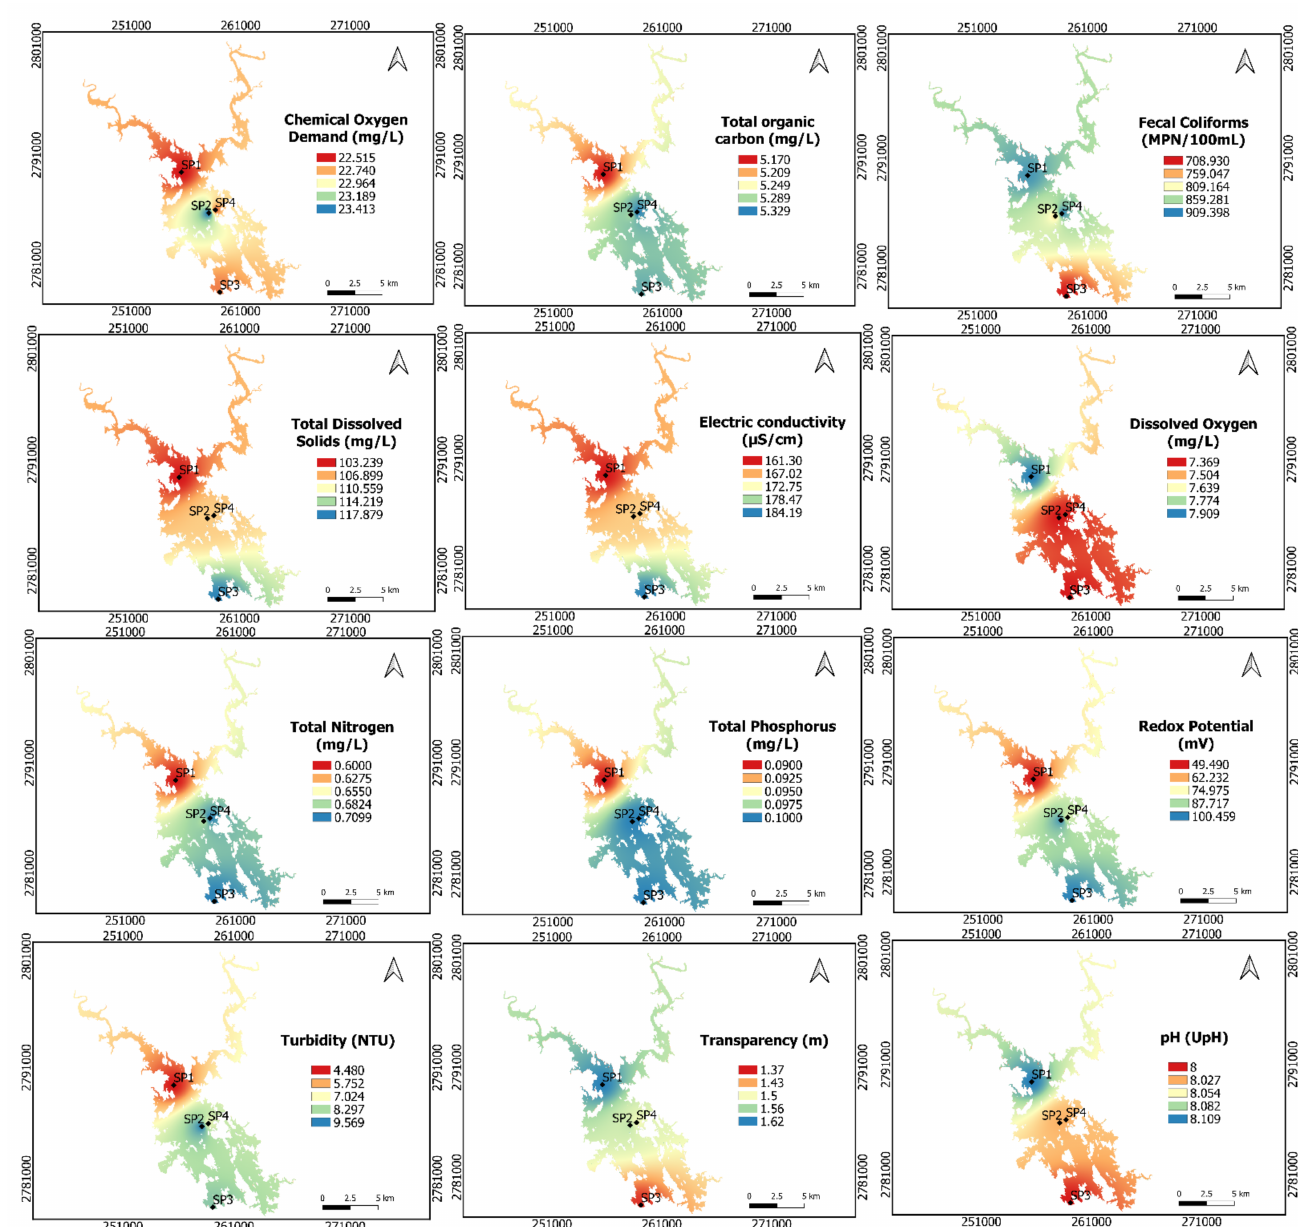
Figure 4. Spatial distribution of water quality parameters in the ALM reservoir using IDW